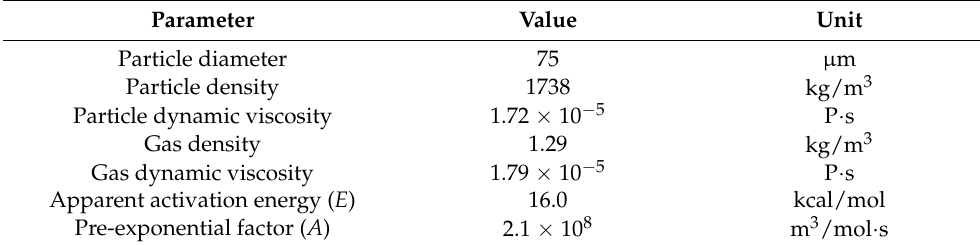
Table 1. Main physical parameters and kinetic parameters for simulation